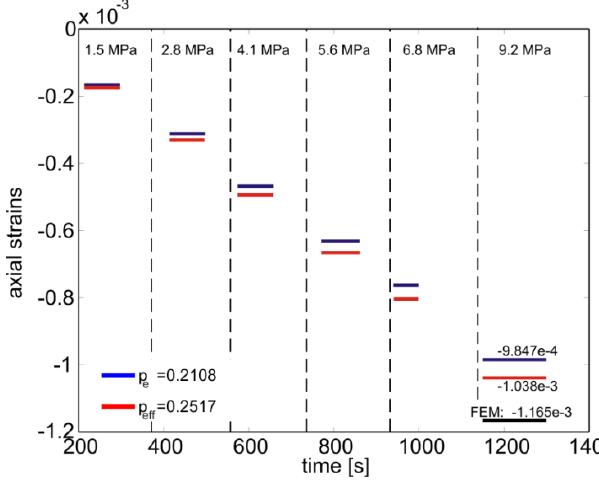
Figure 7. Epoxy cylinder subjected to hydrostatic pressure: comparison between strain calculated from the wavelength measurements and with Equation (4a) and 0.2108 p  . The vertical dashed lines indicate the application well as Equation (6a) and 0.2515 eff e time of each pressure step. The FE prediction for 9.2 MPa pressure is also shown.